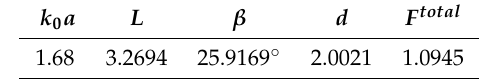
Table 2. The optimized results of the variables and the corresponding wave drift force. k 0 a